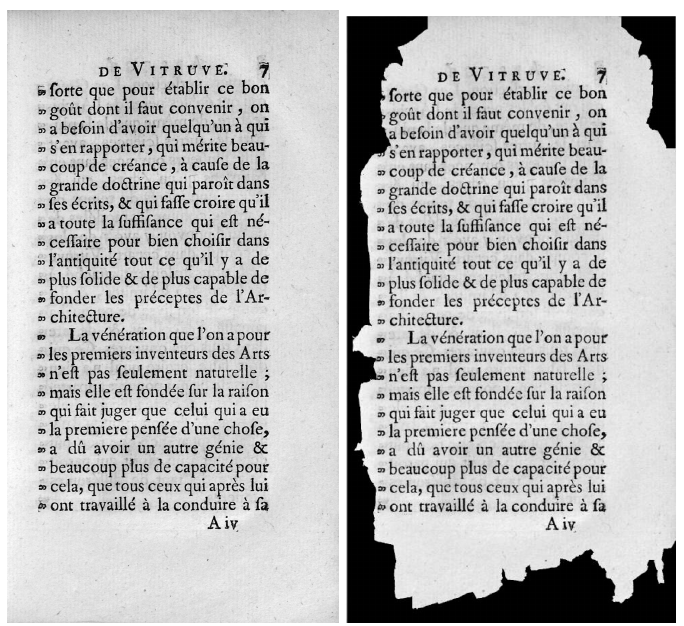
Figure 5. Hole degradation. ( Left ) original images. ( Right ) degraded images.